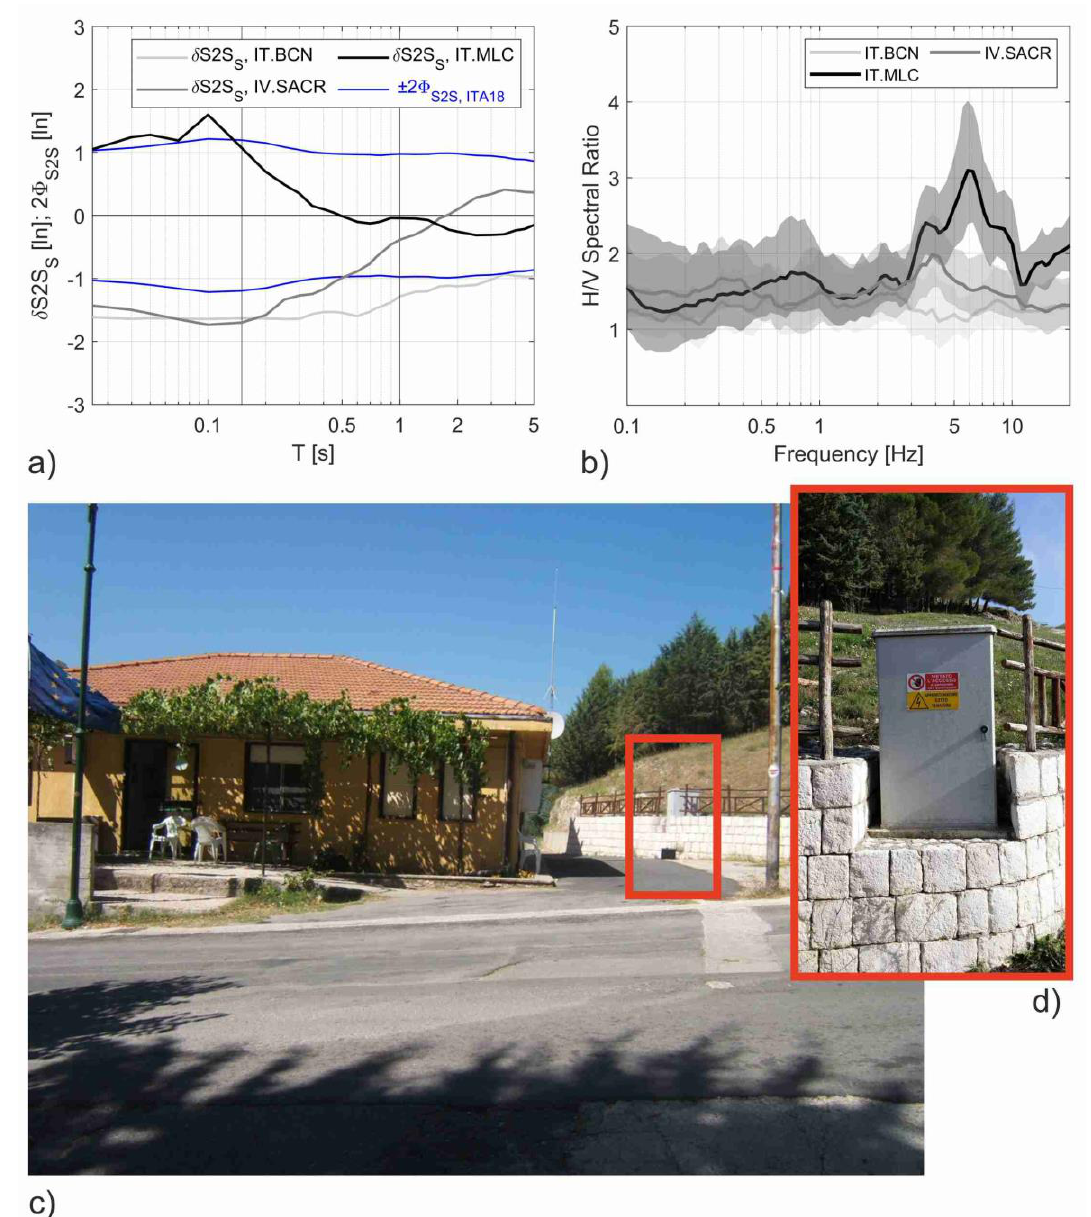
Figure 7. ( a ) examples of peculiar δ S 2 S s residuals in different shades of gray, along with the threshold of 2 Φ S 2 S in blue lines. ( b ) Microtremor H/V spectral ratios, where the solid lines indicate the average values and the gray shadows the corresponding standard deviations. ( c ) Installation site of the IT.BCN seismic station (red box), with a zoom in panel ( d